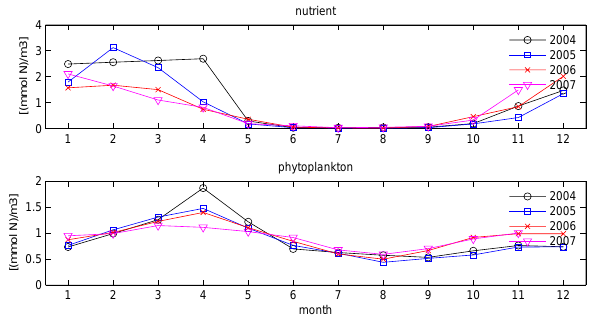
Figure 6. Inter-annual evolution of domain-averaged nutrient concentration (upper 824 panel) and phytoplankton concentration (lower panel) at the MAB shelfbreak. 825 Fig. 6. Inter-annual evolution of domain-averaged nutrient concen- 826 tration (upper panel) and phytoplankton concentration (lower panel) at the MAB